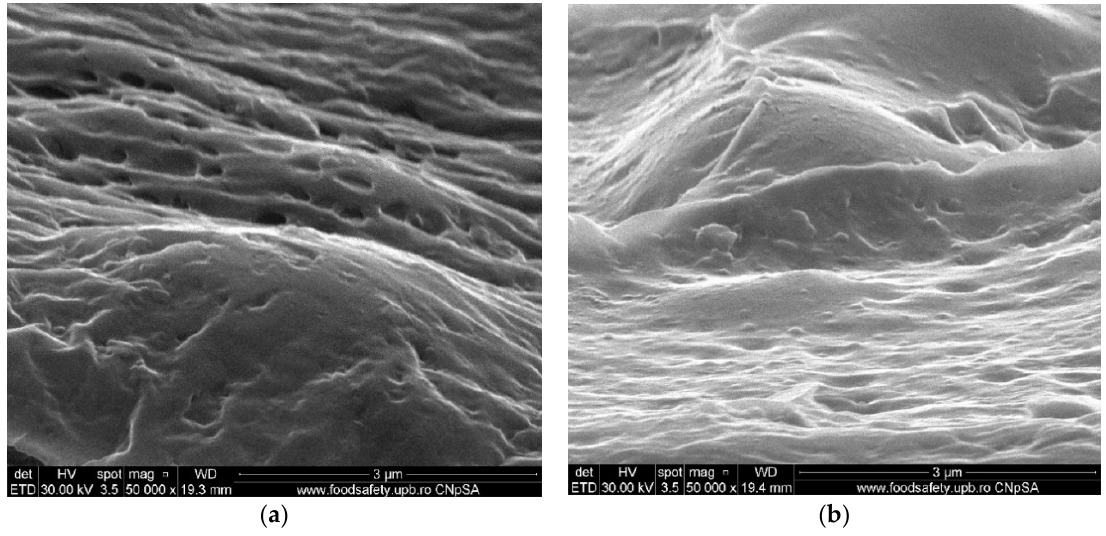
Figure 13. Detail of the superficial layer from the cellulose derivatives: ( a ) cellulose acetate and ( b ) 2–hydroxyethyl cellulose.